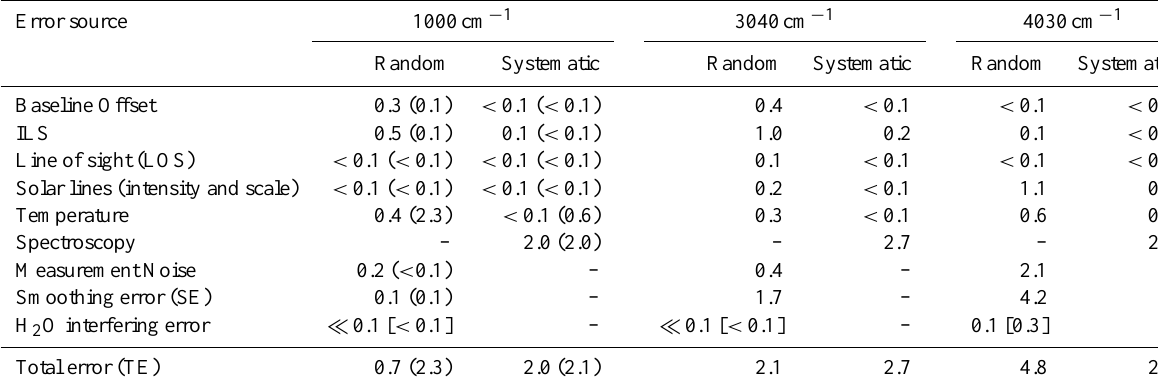
Table 4. Estimated random and systematic errors [%] of OTC for typical measurement conditions of the Izaña spectrometer 120 / 5HR (25 October 2010) for the three analysed spectral regions. ILS: joint error due to the modulation efficiency amplitude and phase error uncertainties; TE: total error due to input parameters, measurement noise, smoothing error and H 2 O interfering error. For the latter the error when H 2 O is simultaneously fitted with O 3 (O 3 retrieval in one-step strategy) is shown in square brackets. Note that the OTC for the 1000cm − 1 region is retrieved considering a simultaneous optimal estimation of the temperature profile (the error when the temperature profile is not fitted with O 3 is given in